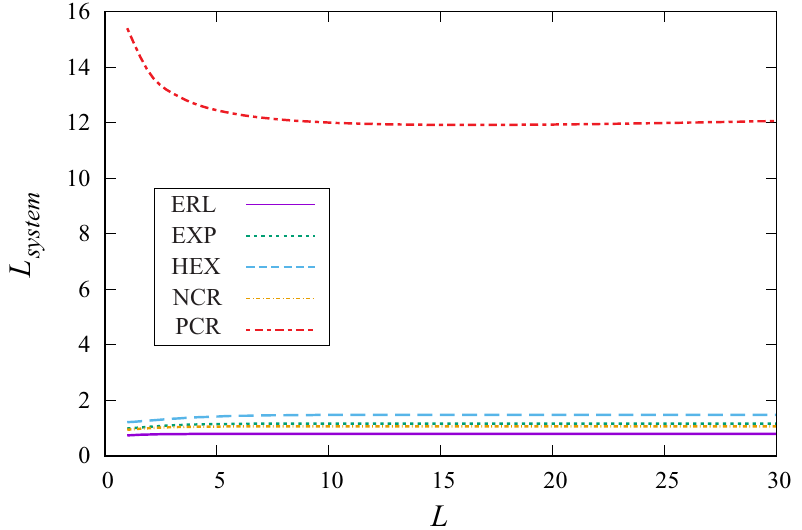
Figure 2. Impact of L on the average number of customers in the system L system for different MAP s.